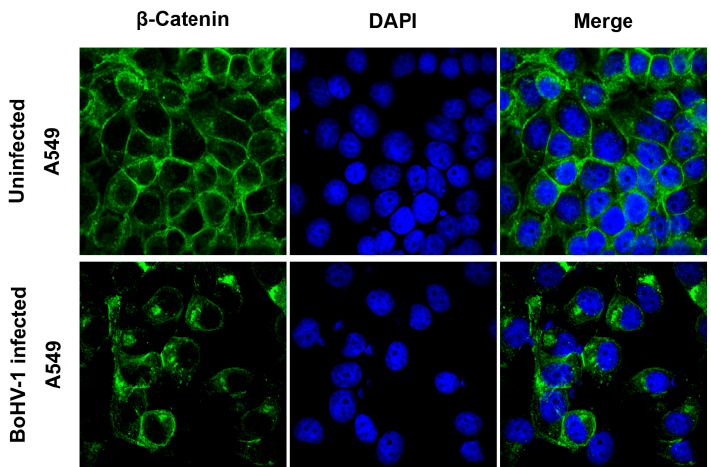
(Figure 5). Taken together, BoHV-1 infection relocalized intracellular β -catenin and induced β -catenin to form cytosolic speckles.